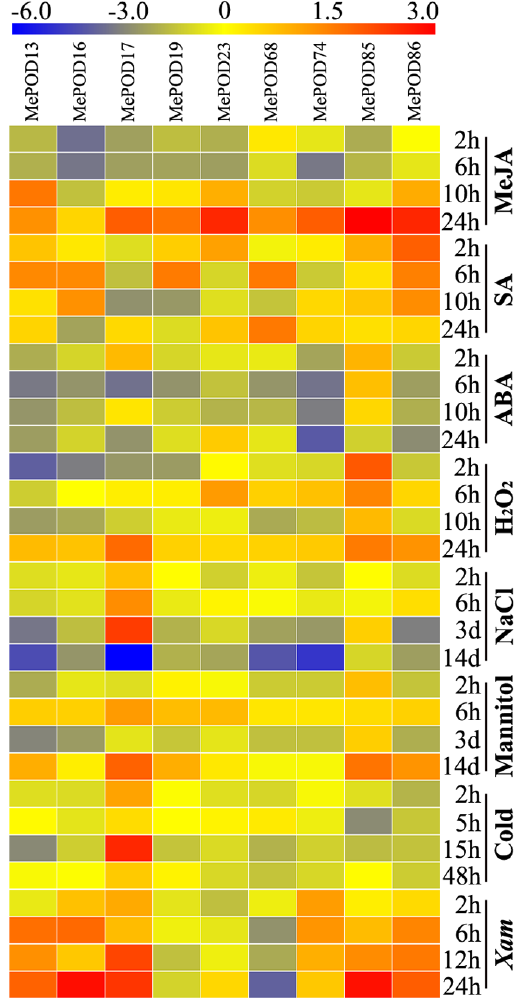
Figure 7. Expression profiles of cassava POD genes in the leaves of Arg7 after exposure to MeJA, SA, ABA, H 2 O 2 , salt, osmotic stress (mannitol treatment), cold stress, and Xam . Log2-based qRT-PCR fold changes were used to build the heat map with Mev4.9.0 software. The changes in color represent the relative gene expression level. 227